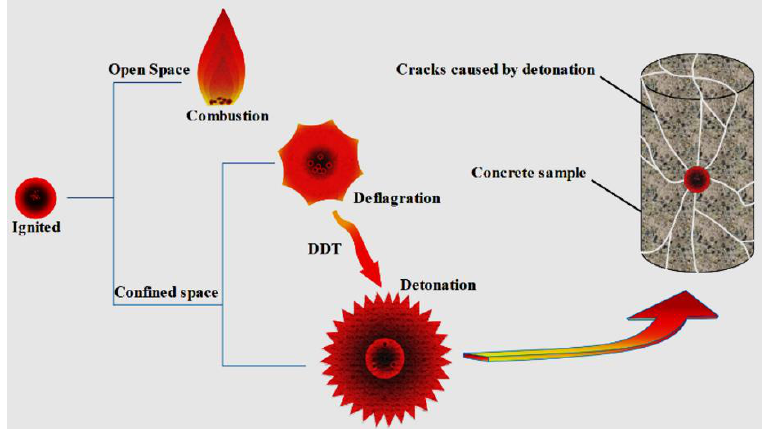
Figure 15. Mechanism of high-energy expander combustion and rock breaking.